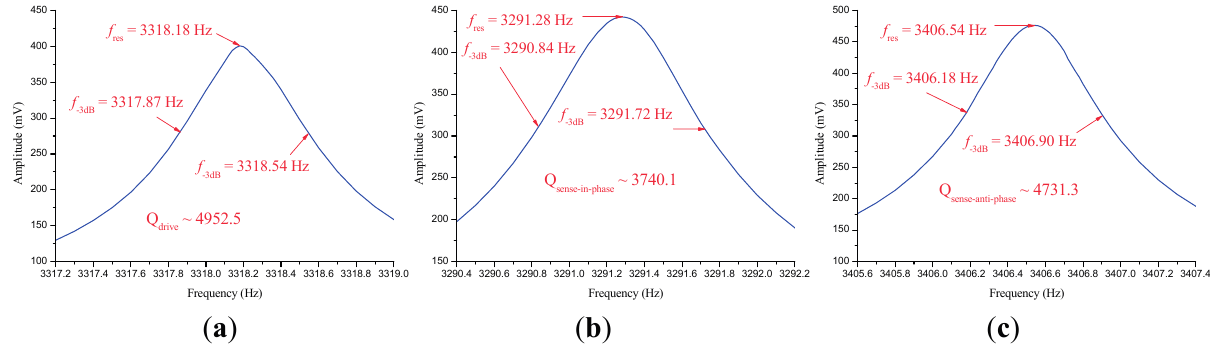
Figure 9. ( a ) The modal spectrum of anti-phase mode in drive direction in SG-1; ( b ) The modal spectrum of in-phase mode in sense direction in SG-1; ( c ) The modal spectrum of anti-phase mode in sense direction in SG-1.